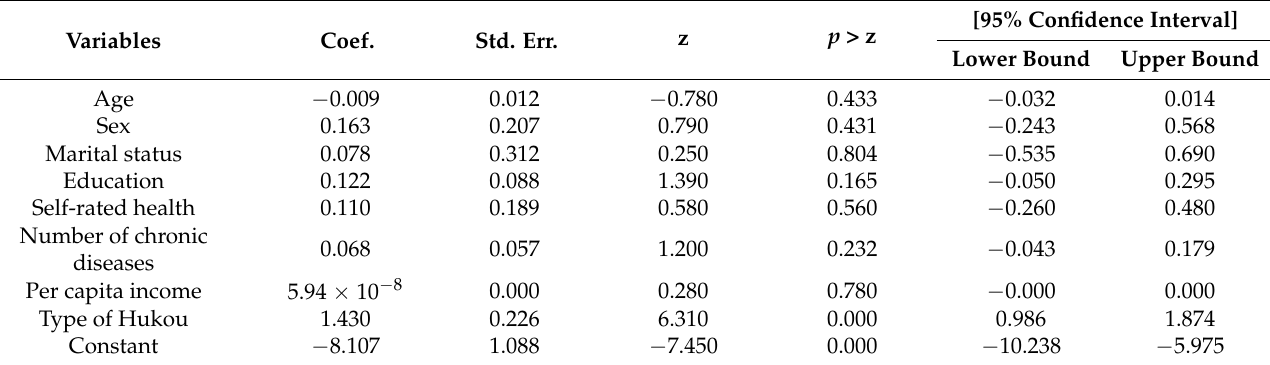
Table A2. Results of Logit